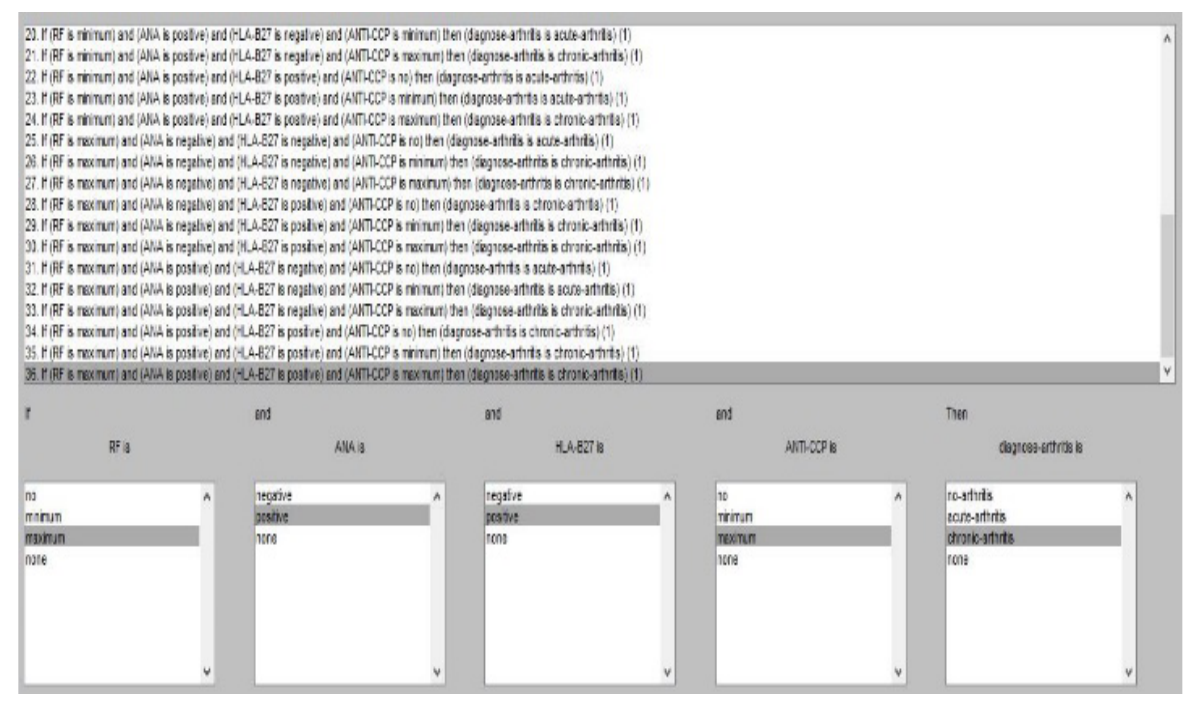
Figure 5. Rules-based system for DA-AH-MFES Adroit System